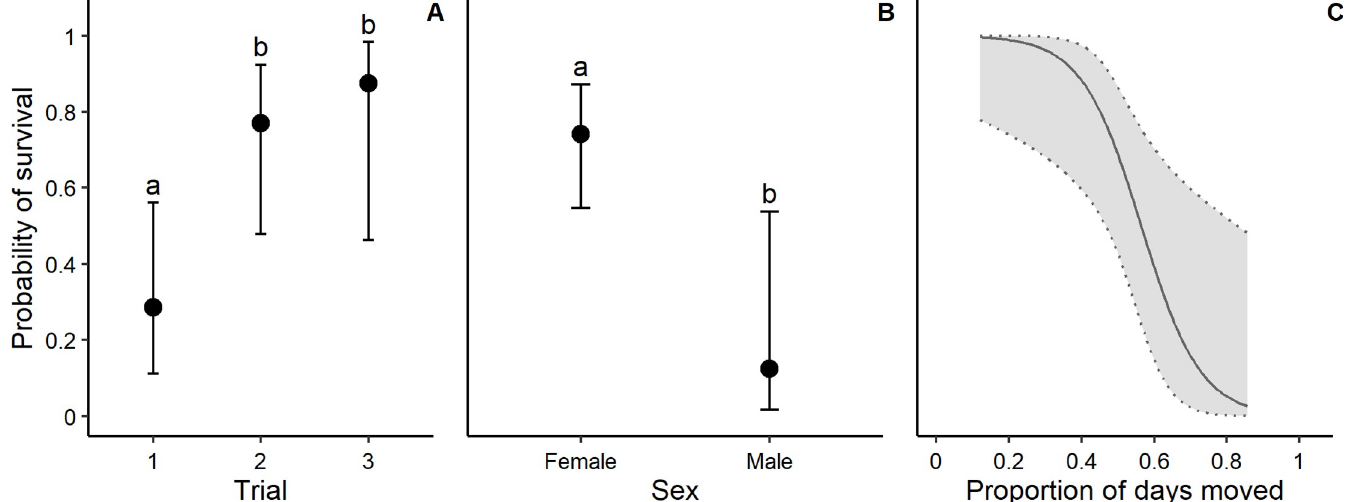
Fig 2. Probability of effective survival for eastern quoll ( Dasyurus viverrinus ) founders translocated to Mulligans Flat Woodland Sanctuary, ACT Australia. Survival presented by trial (2A, Trial 1 n = 14, Trial 2 n = 13, Trial 3 n = 8), sex (2B, female n = 27, male n = 8) and proportion of days moved between dens (2C, n = 29). Male animals were translocated in Trial 1 only. Error bars and dotted lines represent 95% confidence intervals for predicted values, and letters indicate significant differences (where p < 0.05).